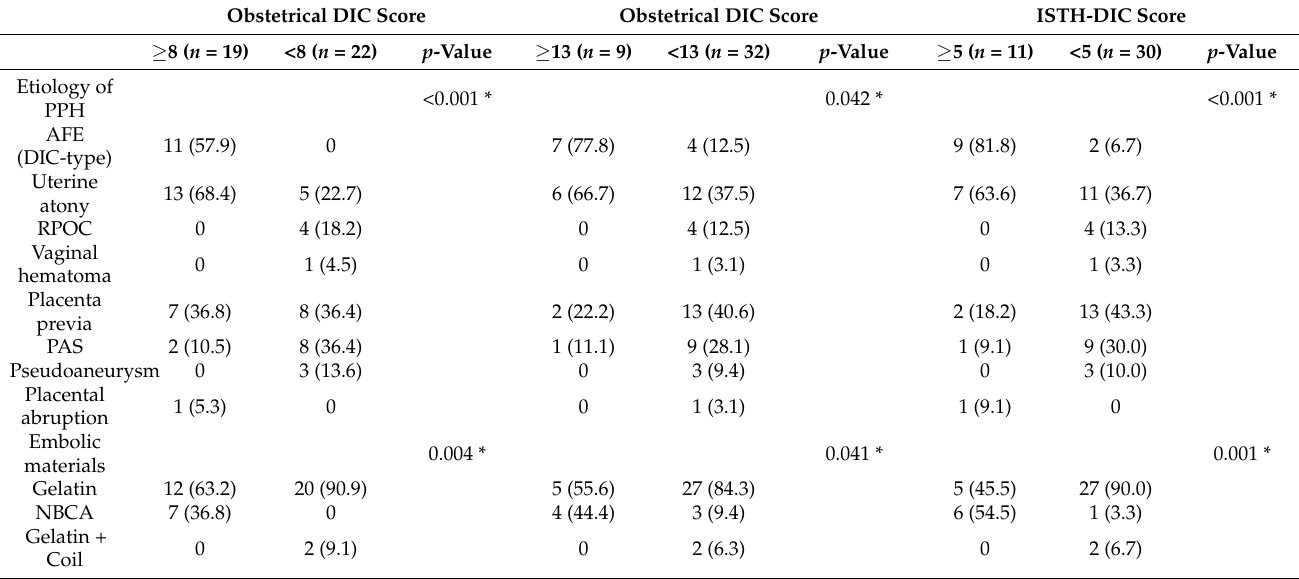
Table 5. Comparison of the PPH etiology and embolic materials used for TAE in patients with or without DIC. Obstetrical DIC Score Obstetrical DIC Score